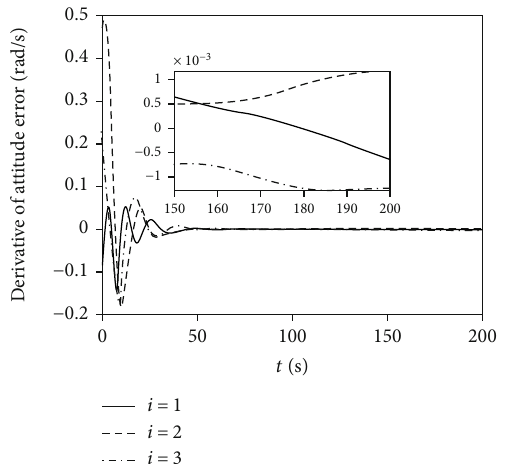
Figure 3: Derivative of e ~